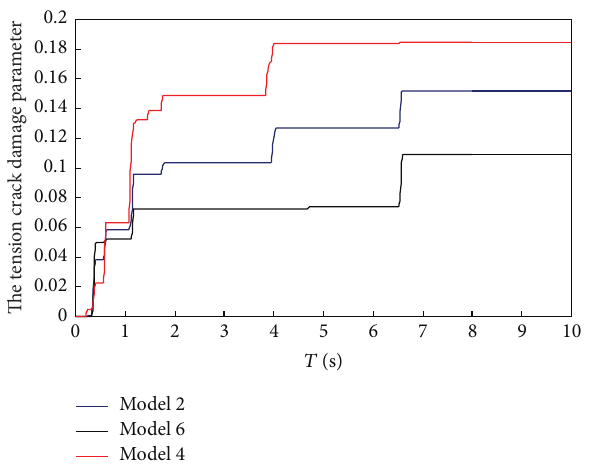
Figure 23: The tension crack damage parameter of pier between windows under Lixian County ground motion.